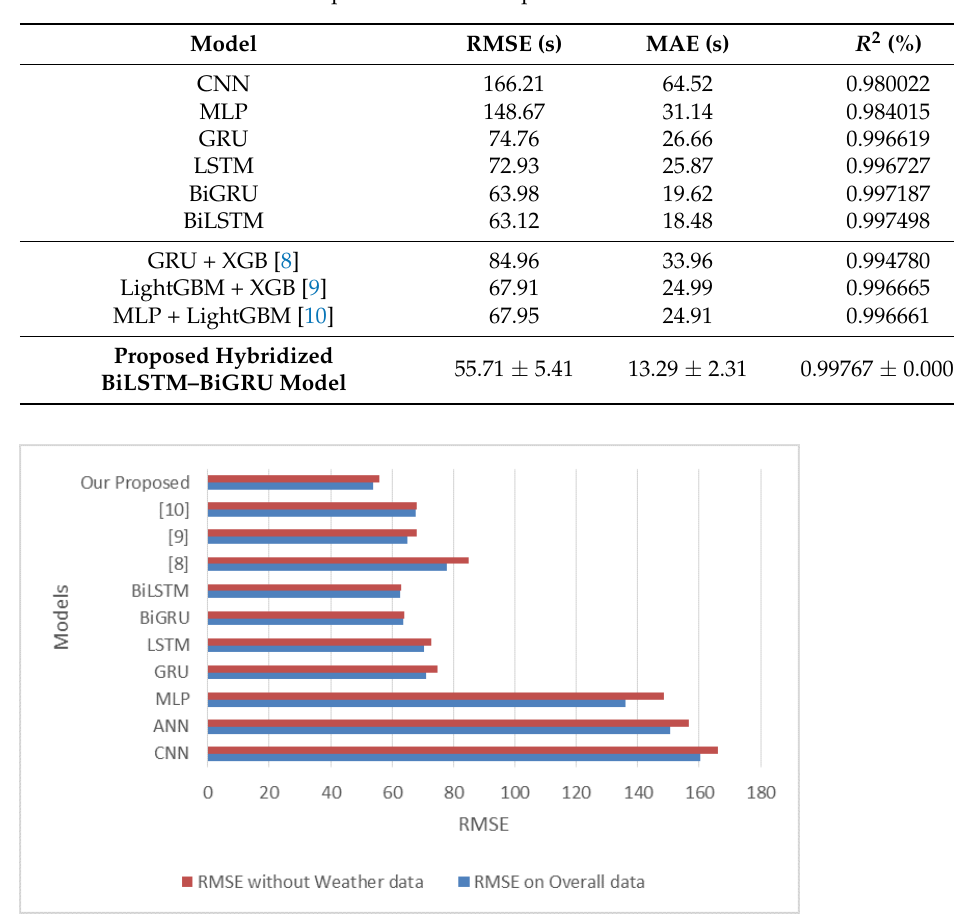
Figure 10. A comparison of the RMSE values with and without the weather data.